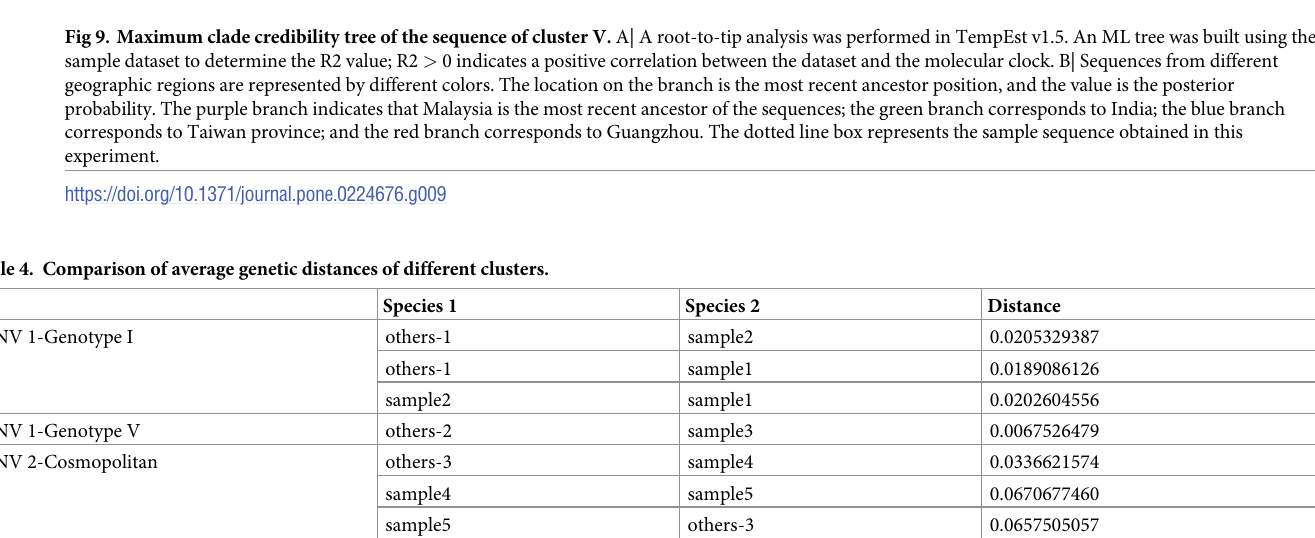
Others in the table indicates the non-sample sequence of the genotype in Guangdong Province from 2014 to